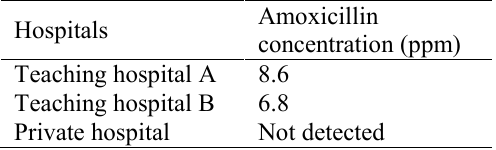
Table 2. Determination of Amoxicillin concentration in hospital wastewater by